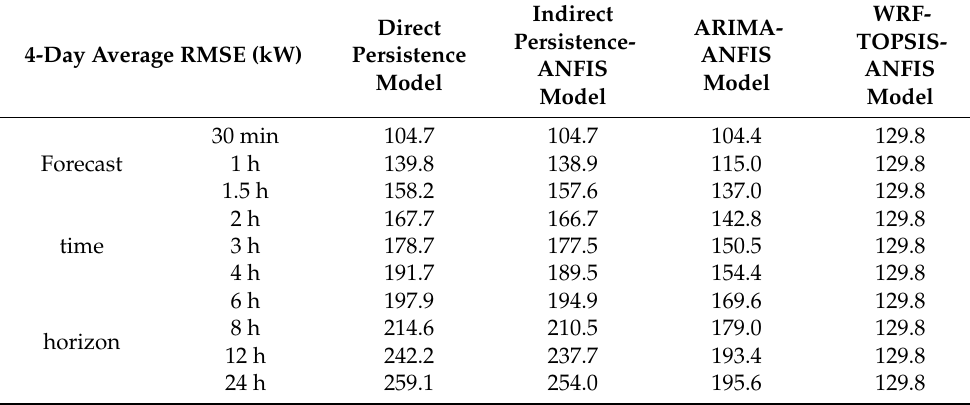
Table 15. Four-day average root mean squared error for the wind power forecasting using the direct persistence, indirect persistence-ANFIS, ARIMA-ANFIS, and WRF-TOPSIS-ANFIS models applied to the 4-day test